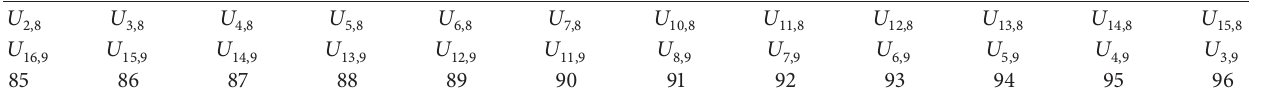
Figure 8: Different locations of simulated stroke lesion set in the model. The radius of the simulated lesion was 0.50 cm. The conductivity of the object was set to 0.65 S/m in the case of simulated hemorrhagic stroke and 0.13 S/m in the case of simulated ischemic stroke (A: anterior; P: posterior; L: left; and R: right). Table 9: SBVPs from electrode pair (8, 9) and electrode pair (10,